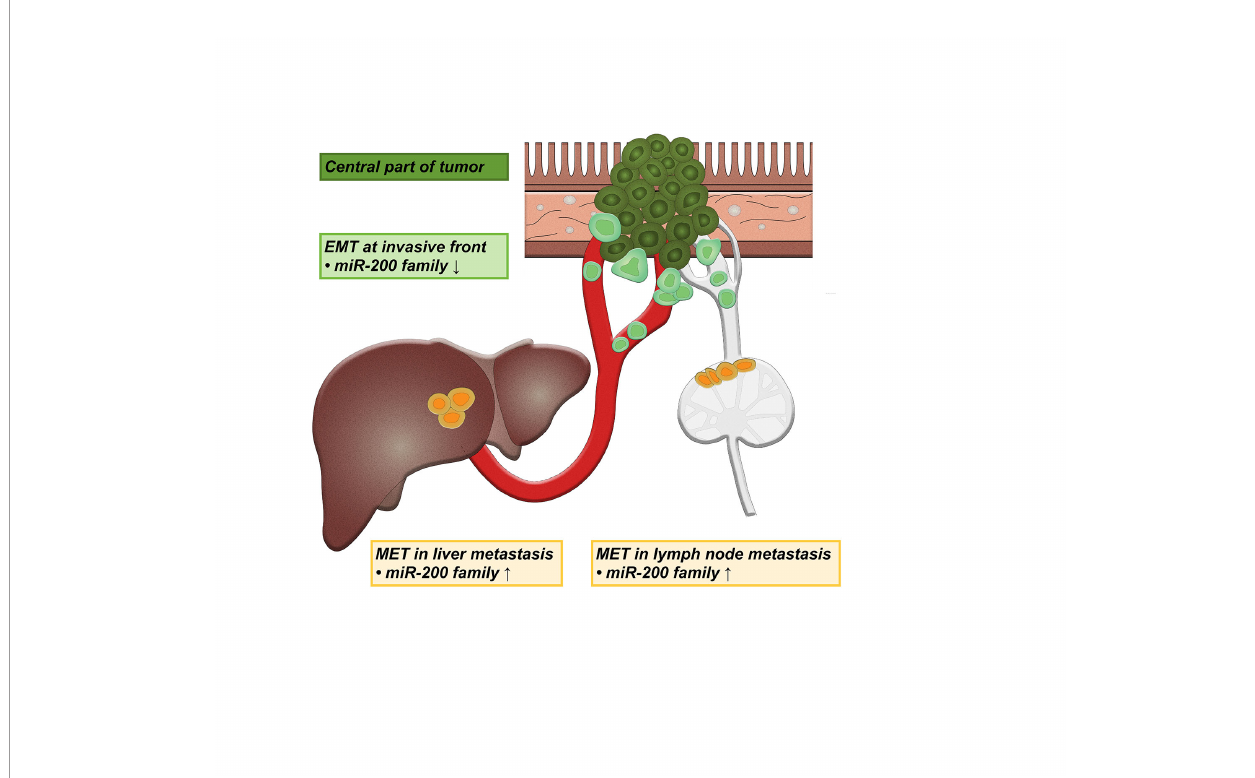
FIGURE 5 | Schematic representation of the involvement of partial epithelial-mesenchymal transition (EMT) and partial mesenchymal-epithelial transition (MET) in lymph node and liver metastases. ↑ up-regulation, ↓